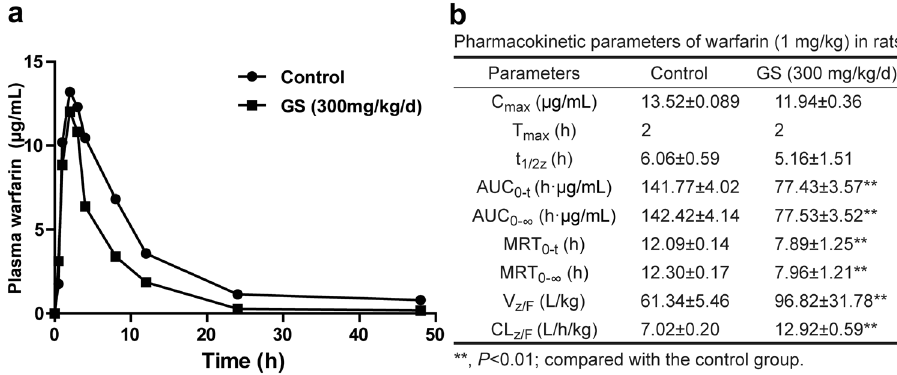
Figure 4. Plasma warfarin concentration-time curve (left) and the related pharmacokinetic parameters (right). A single dose of warfarin (1 mg/kg) was given to rats pretreated with GS (300 mg/kg/day, n = 10) for 3